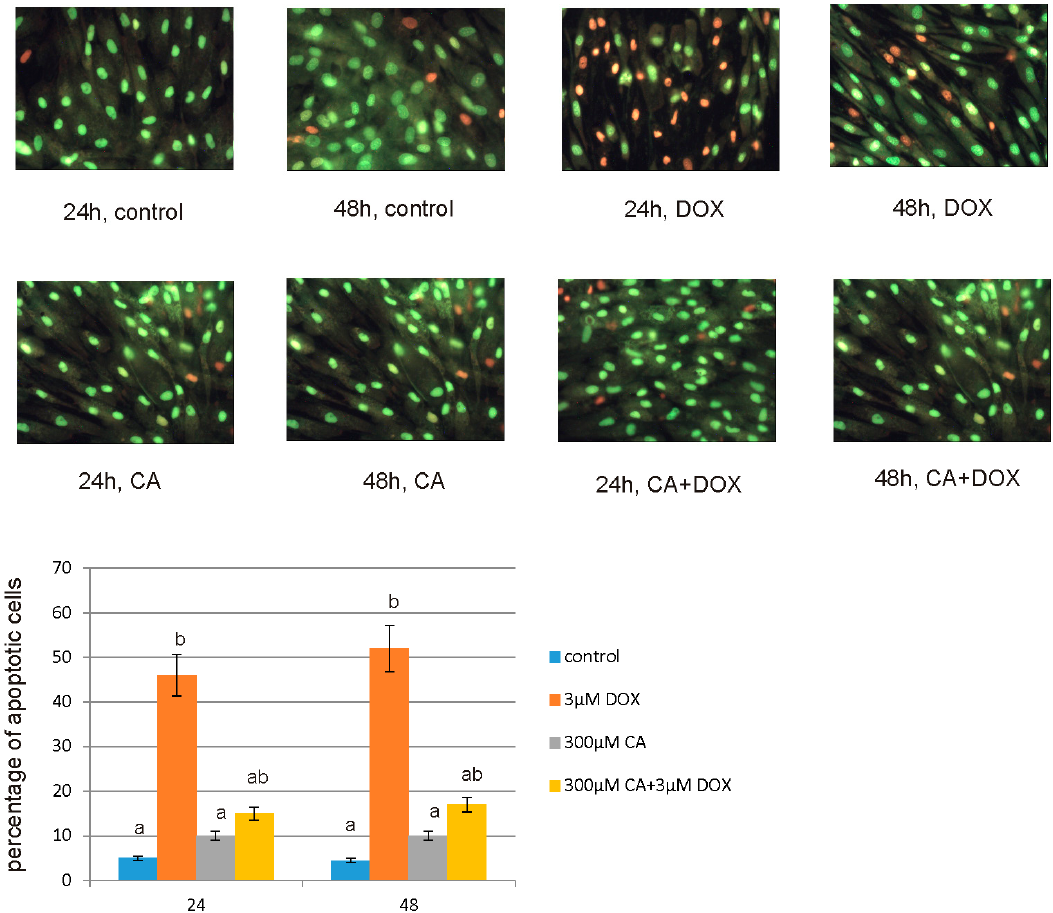
Figure 11. The effect of DOX, CA and CA + DOX on apoptosis and necrosis in the fibroblasts evaluated by fluorescence microscope assay. The cells were incubated in 3 µ M DOX, 300 µ M CA and DOX (3 µ M) combined with CA (300 µ M) for 24, and 48 h and stained with acridine orange and ethidium bromide. The cells were photographed under a fluorescence microscope at 200× magnification. We presented representative images from one of three independent experiments and the percentage of apoptotic cells on the graph. Different letters (a, b) indicate statistical differences ( p ≤ 0.05) between control, 3 µ M DOX, 300 µ M CA and DOX combined with CA estimated by Tukey’s test